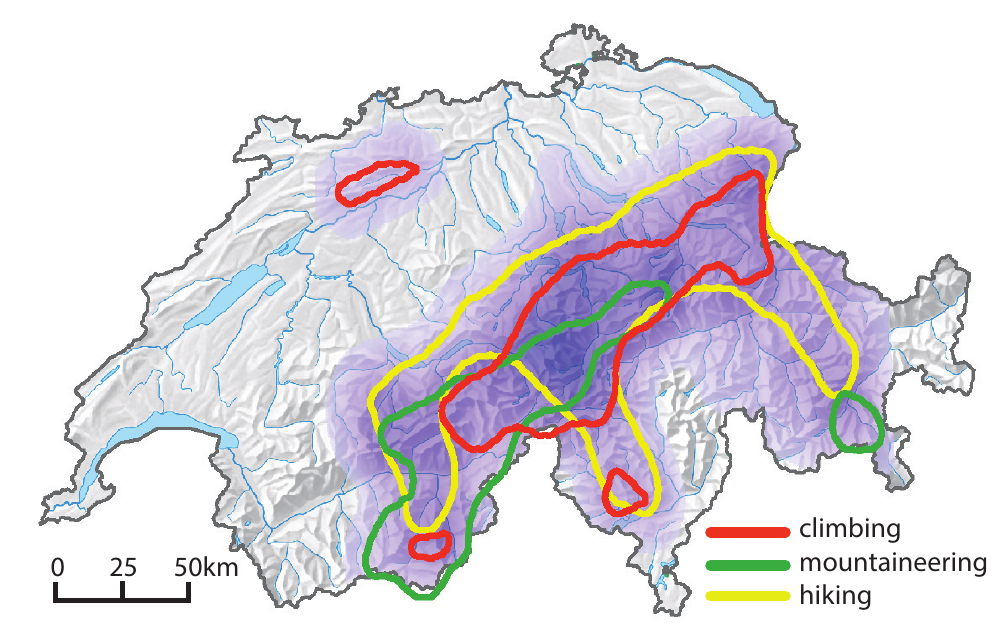
Figure 7: Spatial representation of all queries (n=4354). The blue background color shows the density of all spatial queries, with the three contour lines identify the 80% densest regions for different